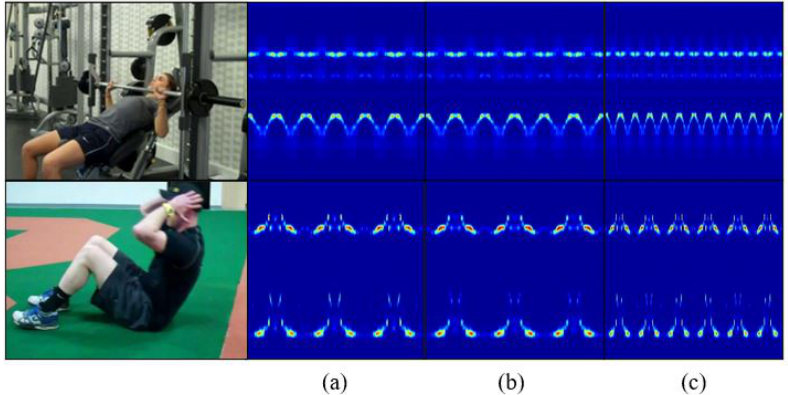
Figure 6. Explanation of videos with different cycles and speeds. This image shows the motion of right wrist in two exercises: bench press and sit up. ( a ) 6 cycles and low speed. ( b ) 6 cycles and fast speed. ( c ) 12 cycles with middle